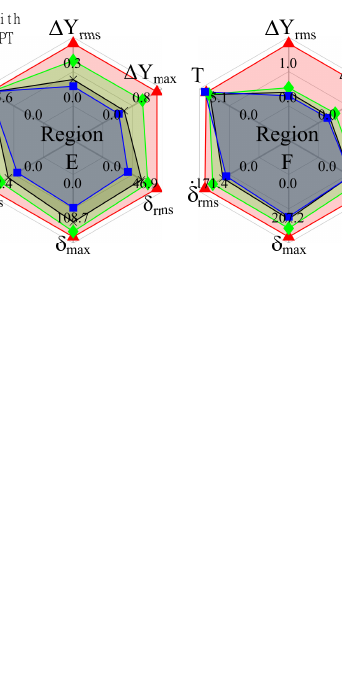
Figure 17. Scenario 1—Completion time for track regions.